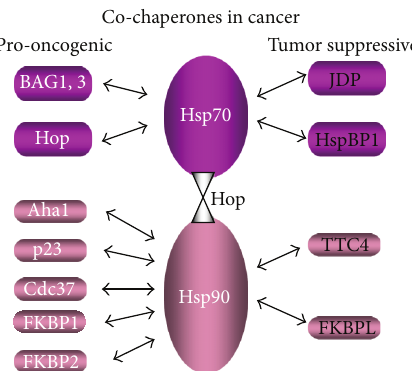
Figure 3: Oncogenic or tumor suppressive influence of molecular co-chaperones. (Hop is shown twice in the cartoon to depict its role